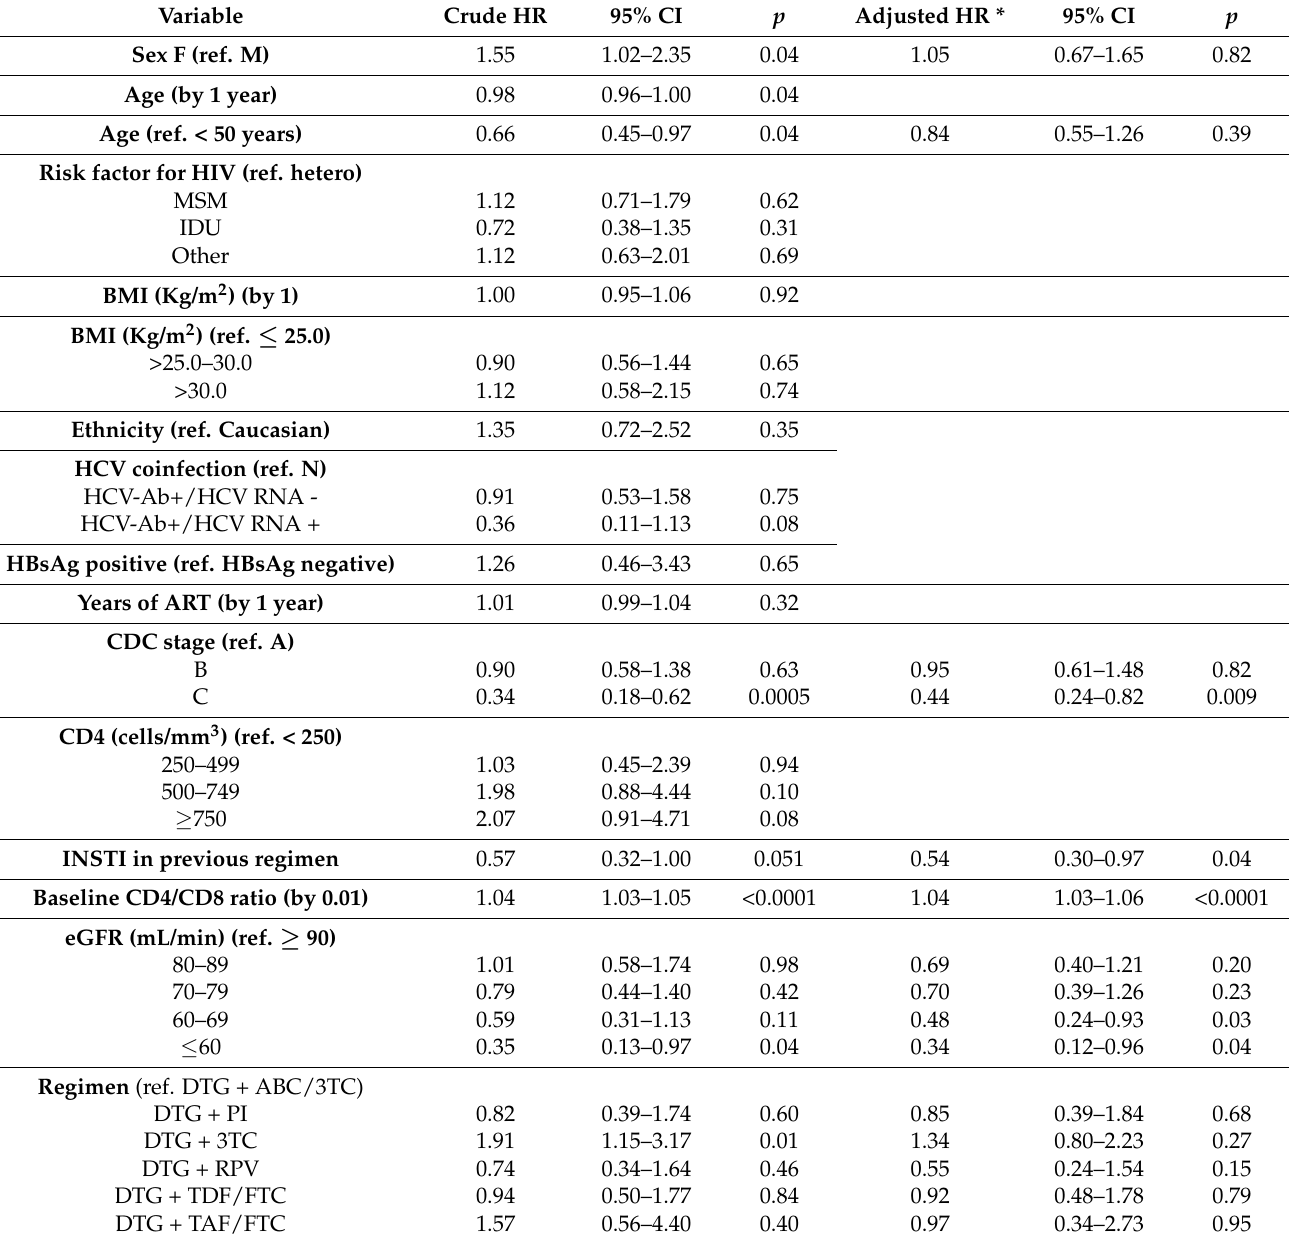
Table 4. Hazard ratios for CD4/CD8 ≥ 1.0 in people living with HIV on 2DR and 3DR DTG-based regimens, according to baseline characteristics.